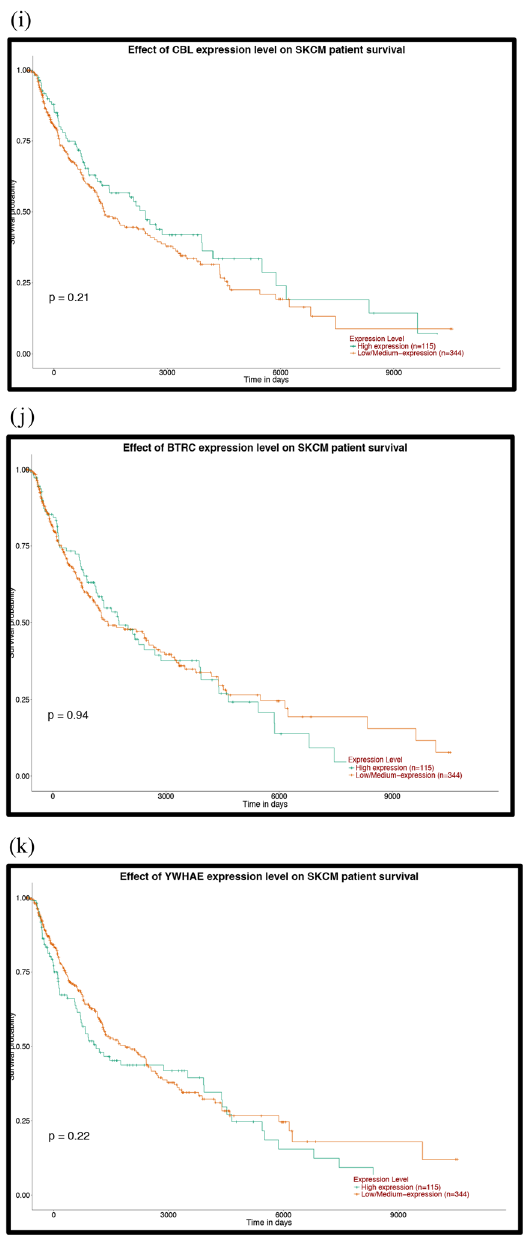
Figure 6: Prognostic analysis of the mutant genes and the hub genes of the downregulated miRNAs with the UALCAN database: ( a ) TP53, ( b ) FAT4, ( c ) PTPRT, ( d ) GRIN2A, ( e ) EP300, ( f ) MAPK8, ( g ) PTEN, ( h ) HSPA8, ( i ) HSP90AA1, ( j ) APP, ( k ) POLR2A, ( l ) RPL23, ( m ) SP1, ( n ) ITPKB, ( o ) RBBP4, ( p ) YY1, ( q ) SMAD2, ( r ) MMP2 and ( s ) CXCR4. P < 0.05 was considered statistically signi fi